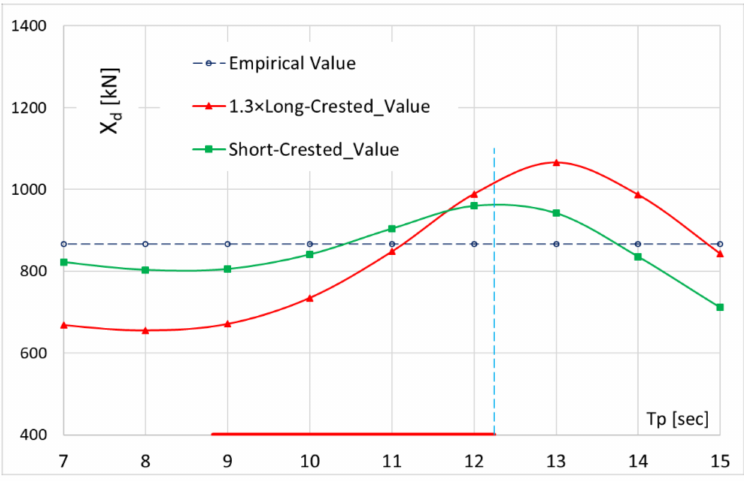
Figure 5. Predicted mean added resistance using recommended